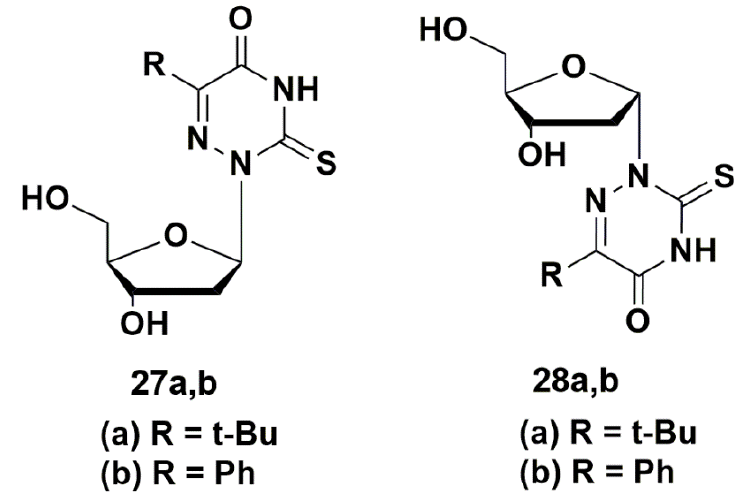
Figure 6. Structures of 5-modified 6-aza-2 (cid:48) -deoxyuridines. The synthesized 5 (cid:48) -norcarbocyclic uracil derivatives (Figure 7) demonstrated anti- tuberculosis activity against both the laboratory (H37Rv) and multidrug-resistant (MS-115) Mtb strains. All compounds, except for 1-(4-hydroxy-2-cyclopenten-1-yl)-5-tetradecynyluracil ( 29c ), showed moderate inhibitory activity on the laboratory strain H37Rv (MIC 99 20–40 µ g/mL). The compound 29c as racemic mixture completely suppressed the growth of mycobacteria at MIC 99 10 µ g/mL. Individual enantiomers of the compound 27c were isolated using enzymatic separation with Amano PS lipase [61] and tested against MDR strain (MS-115). The racemic mixture 29c as well as (+) 29c enantiomer inhibited the growth of the resistant strain MS-115 at MIC 99 10 µ g/mL. At the same time, it was shown that the ( − ) 29c enantiomer inhibited the growth of laboratory strain H37Rv at MIC 99 5 µ g/mL [49]. Compound 29c had no toxicity in Vero cell cultures up to the highest tested concentration (CC 50 > 125 µ g/mL).